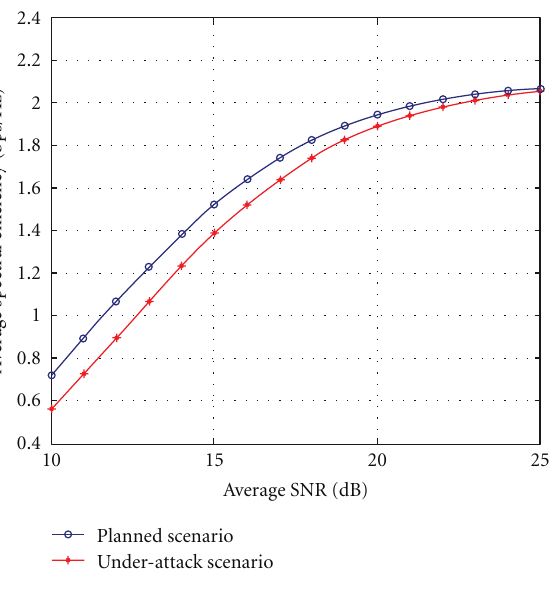
Figure 2: ASE in di ff erent scenarios.